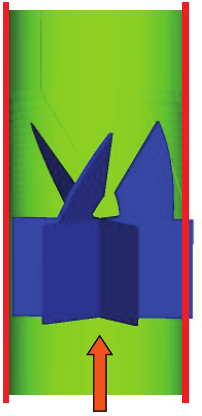
Figure 2: View of the mixing